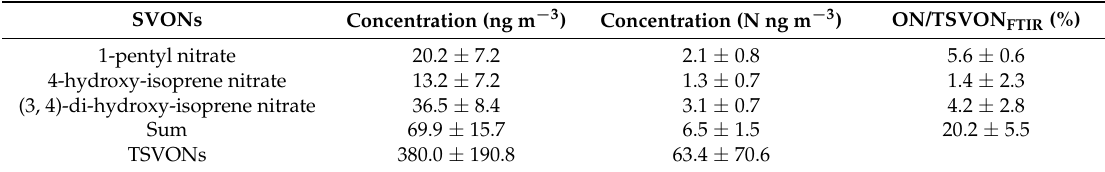
Table 2. Concentrations of the three SVONs and their ratios to total SVONs